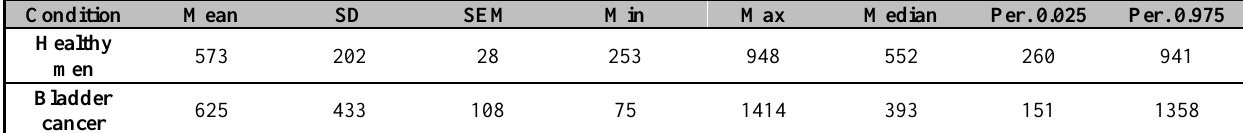
Table 1. Some basic statistical parameters of Zn concentration (mg/L) in prostate fluid of health men and patients with bladder